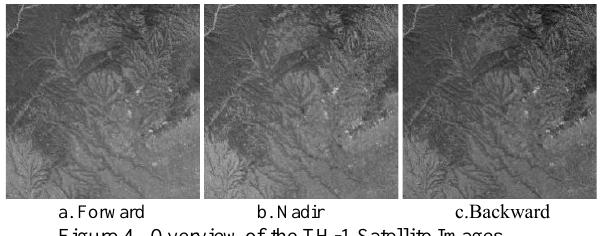
Figure 4. Overview of the TH-1 Satellite Images